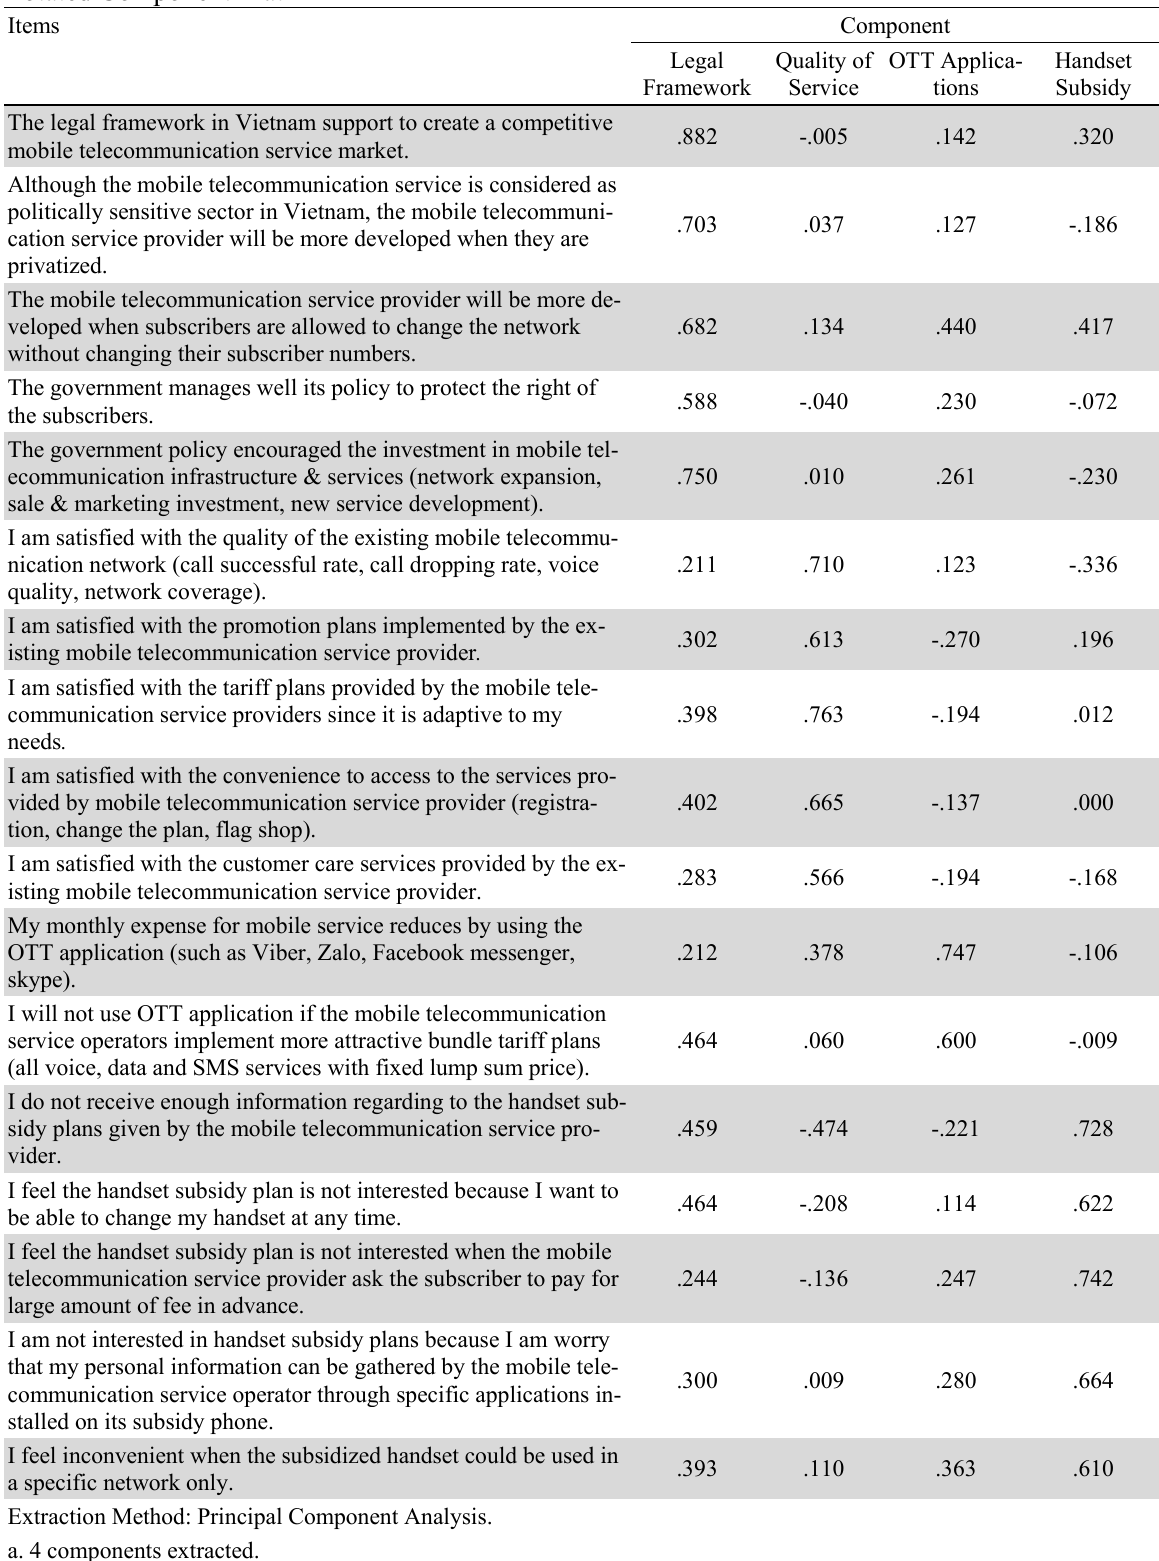
Rotated Component Matrix Items Component